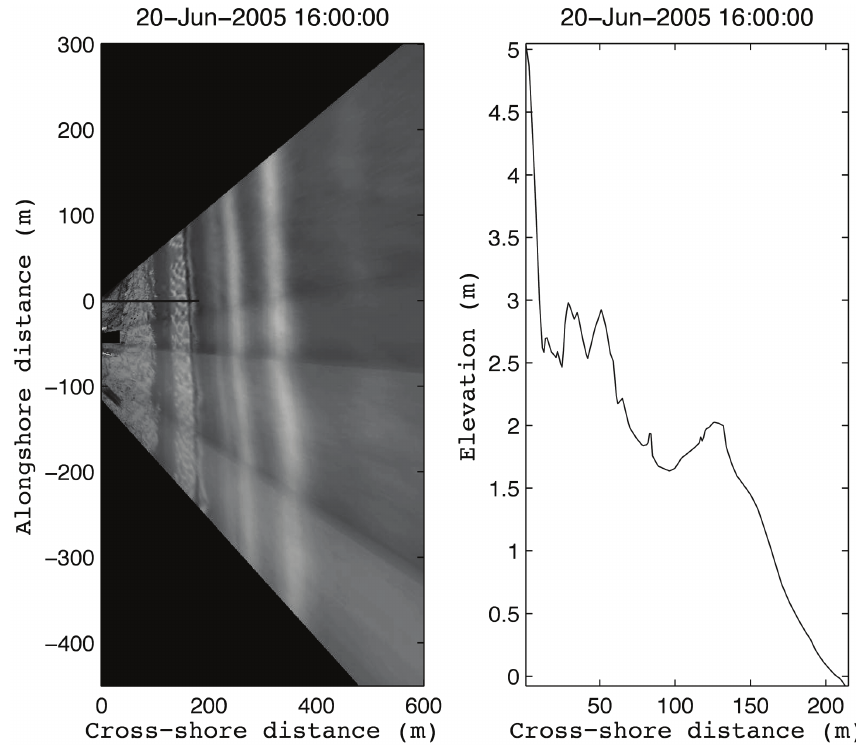
Figure 5 - In the left Sample Argus image with dunes at the backshore zone and the corresponding beach profile. On the right, surveyed at the same time as the Argus images were